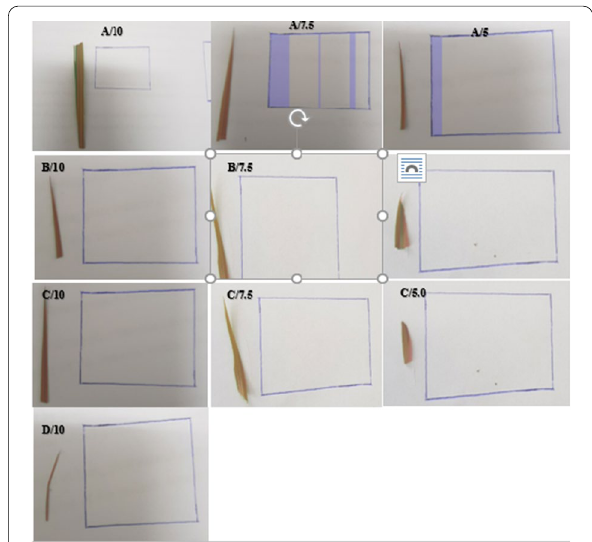
Fig. 9 Seedling vigor index. Results with similar alphabets on same bars did not differ from each other (p>0.05).